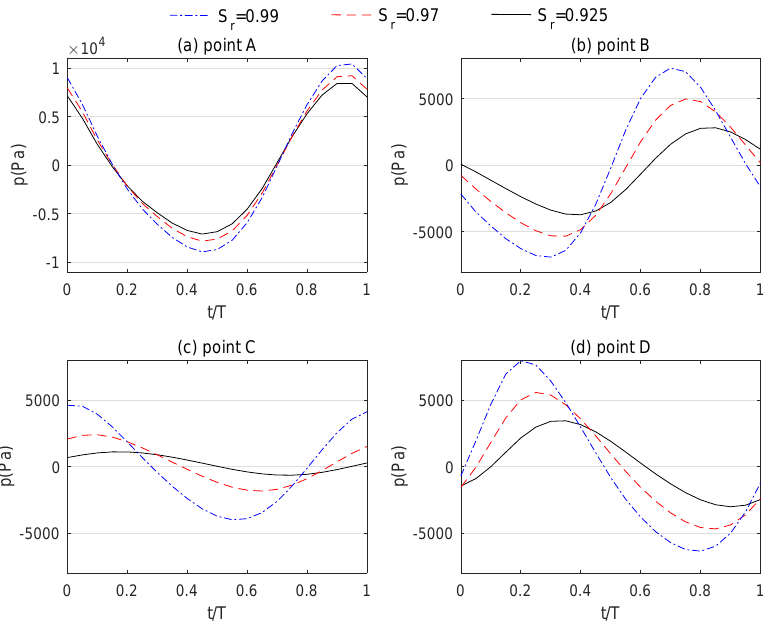
Figure 16. Distributions of the pore pressure over time in one period on four points with various degrees of saturation ( S r